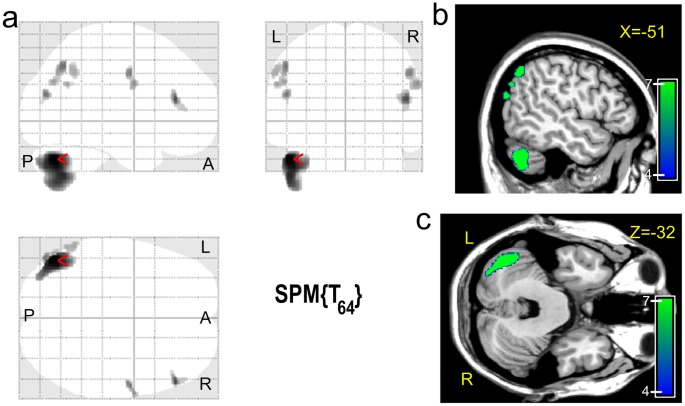
Anatomical regions with significant reductions in white matter volume in treatment-naïve depressed patients relative to healthy subjects.Significance threshold with a family wise error (FWE) at p<0.05 and cluster size ≥20 voxels was used.